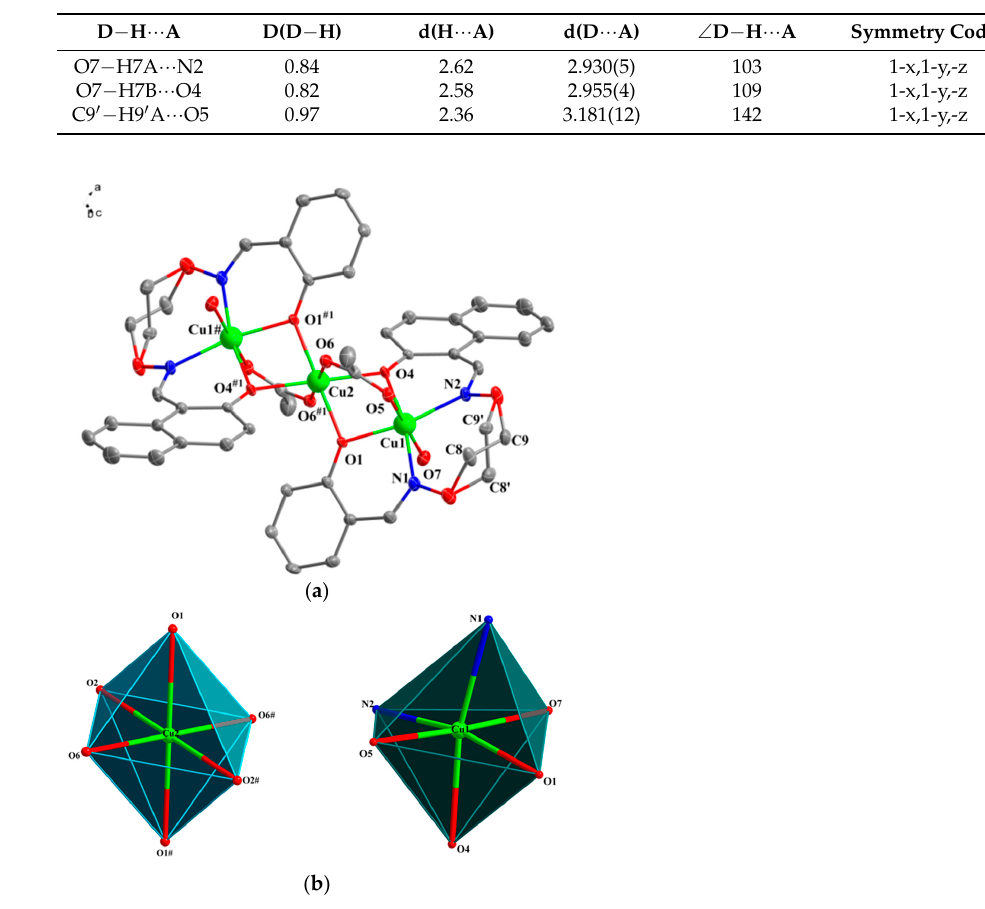
Figure 3. ( a ) Crystal structure of the Cu II complex; ( b ) Coordination polyhedra of the Cu II atoms. Table 3. Significant bond lengths (Å) and angles ( ◦ ) of the Cu II complex.